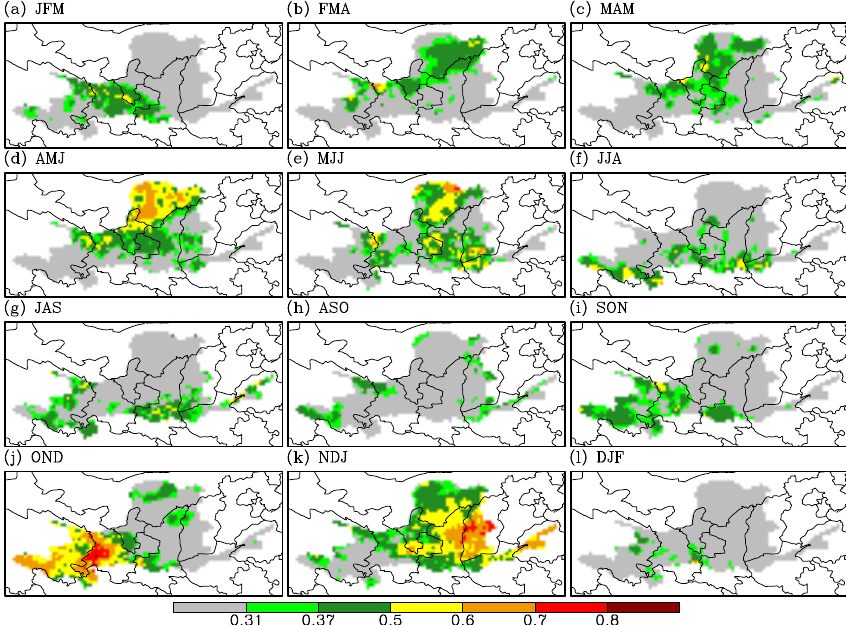
Figure 3. Spatial distributions of grid-scale AC of grand NMME ensemble forecasts for seasonal mean precipitation.